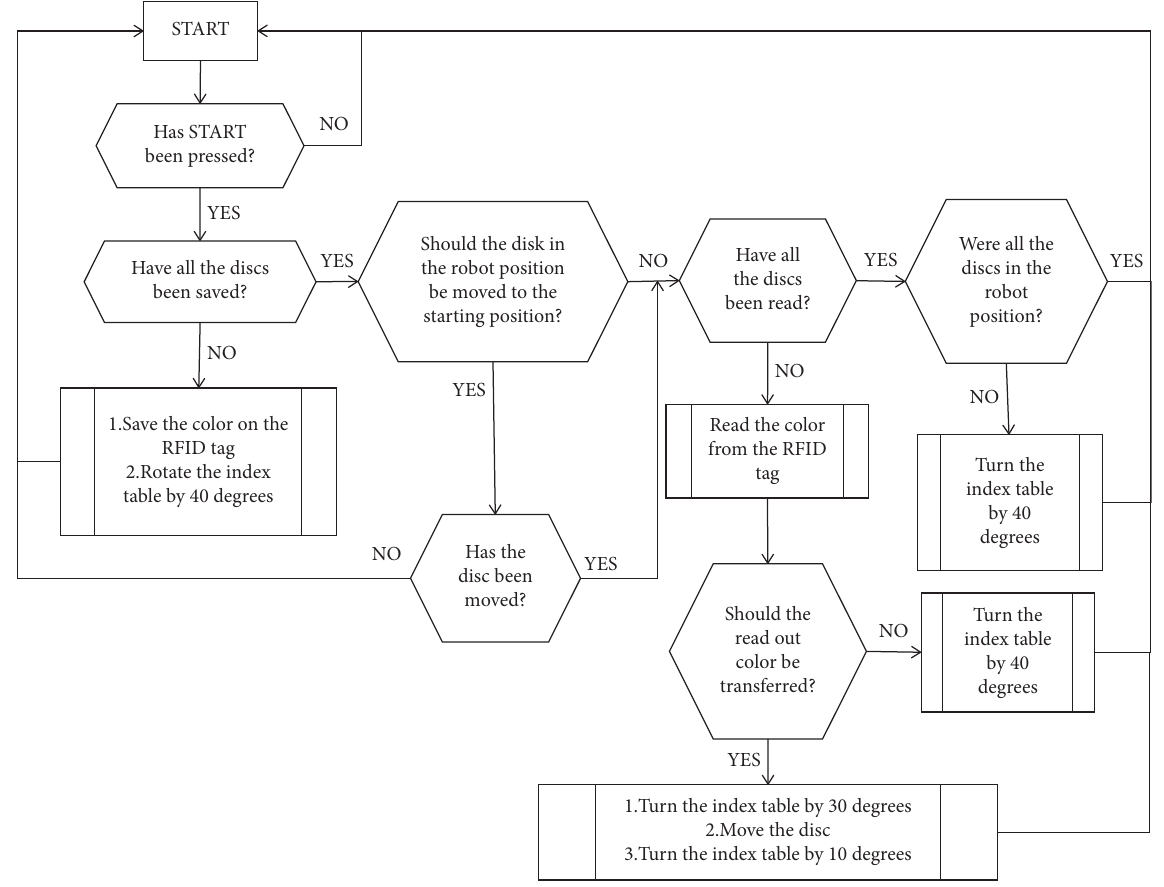
Figure 6: Algorithm of operation of the station.